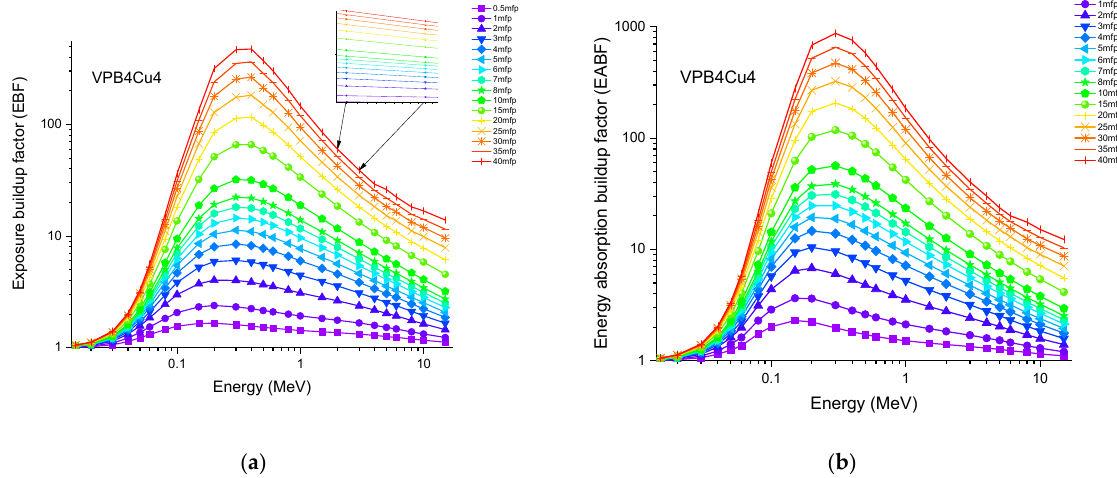
Figure 13. Variation of ( a ) EBF and ( b ) EABF against photon energy for sample VPB4Cu4.